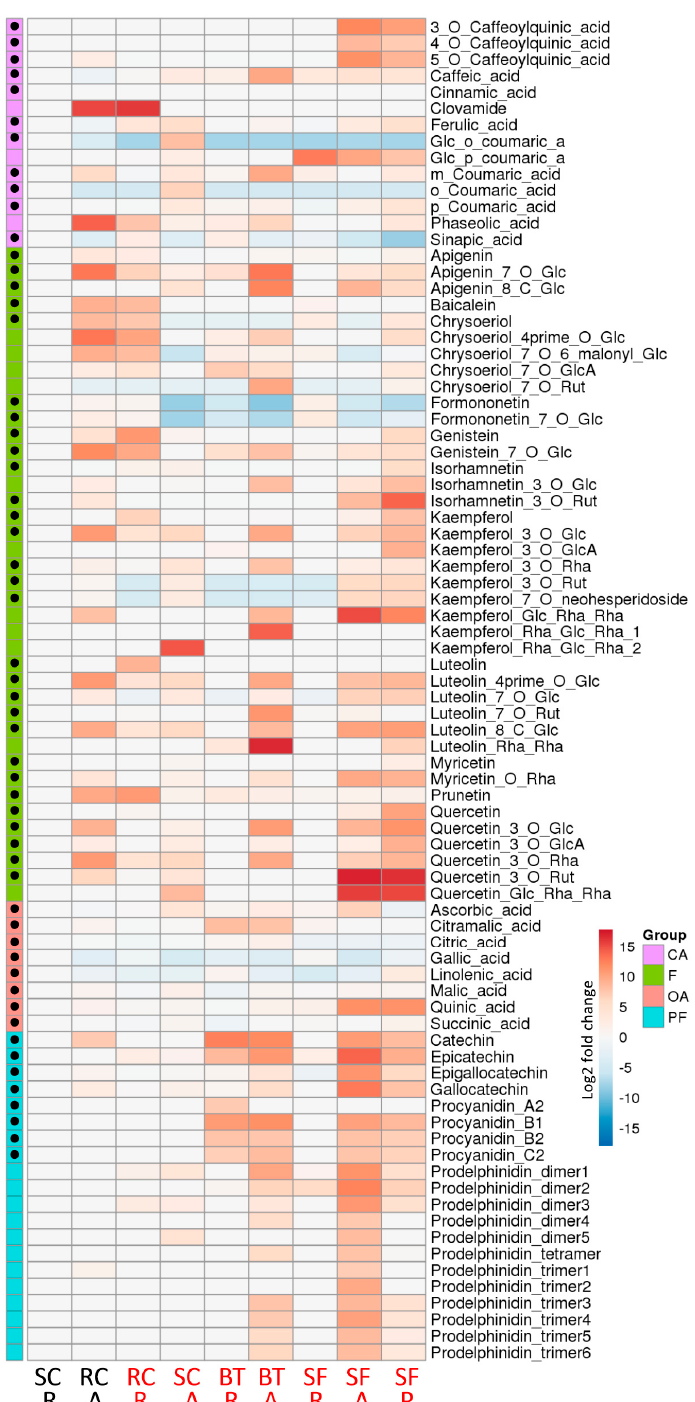
Figure 3. Comparative metabolomic analysis of Fabaceae extracts. Mean relative abundance of the selected metabolites are presented as Log2 ratios compared to the weakly nematicidal root extract of sweet clover (SC-R), with shades of red or blue colors according to the scale bar. Metabolites are grouped as cinnamic acid and derivatives (CA), flavonoids (F), organic acids (OA) and proantho- cyanidins and flavanols (PF). Identity of the metabolites indicated with black dots was confirmed with the corresponding standard. SF: sainfoin, BT: birdsfoot trefoil, RC: red clover, SC: sweet clover, A: aerial parts, R: roots, P: pellets. Weakly nematicidal and highly nematicidal extracts are indicated in black and red, respectively. Glucoside: Glc; glucuronide: GlcA; rhamnoside: Rha; rutinoside: